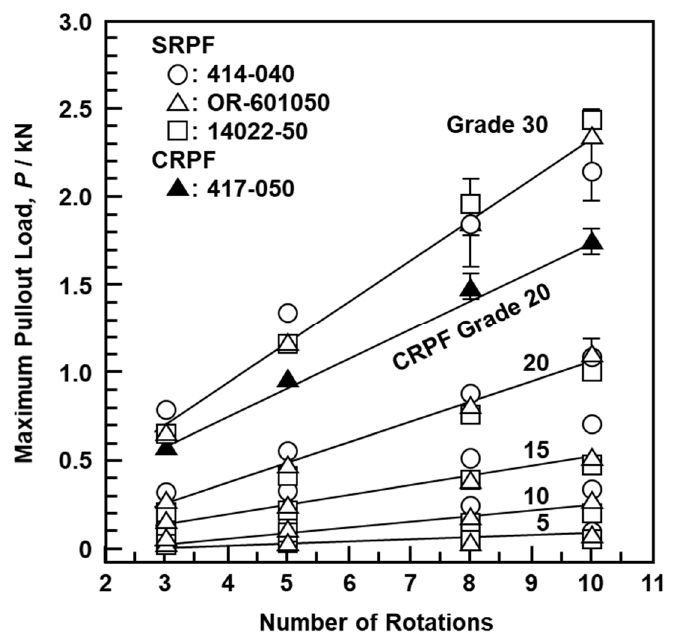
Figure 12. E ff ect of number of rotations on maximum pullout load with S-bone SRPF and grade Figure 12. Effect of number of rotations on maximum pullout load with S ‐ bone SRPF and grade 20 20 CRPF.